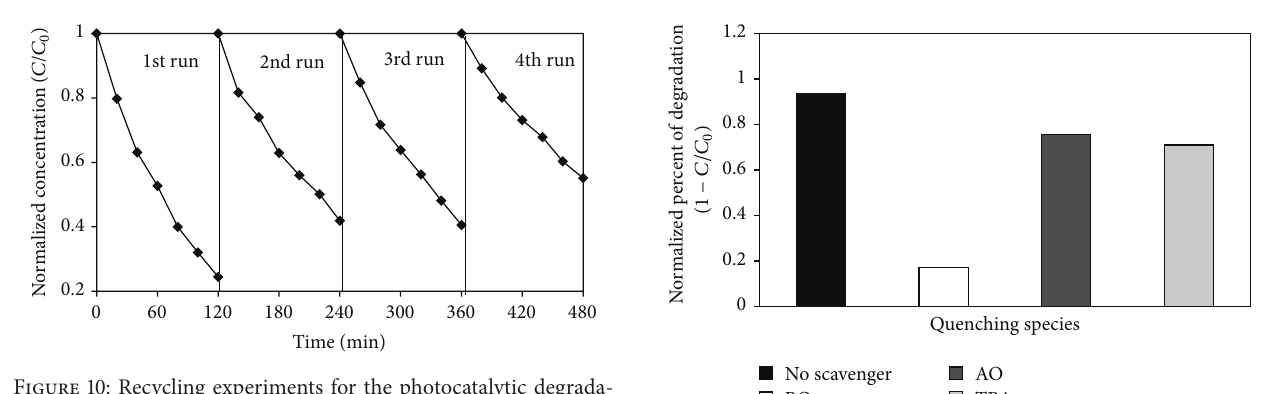
Figure 10: Recycling experiments for the photocatalytic degrada- tion of RhB.